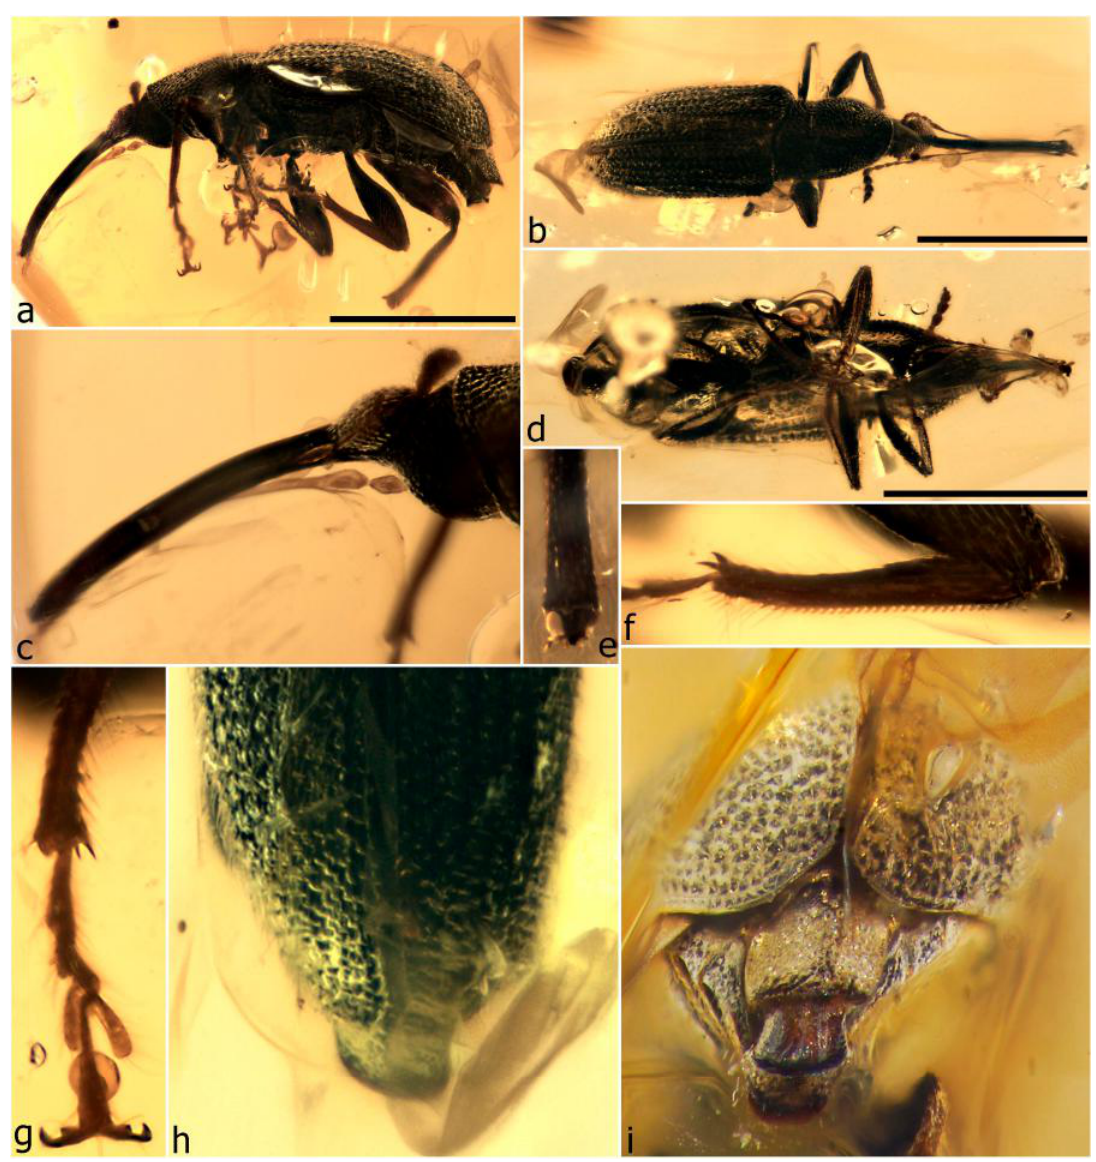
Figure 86. Bowangius tanaops sp. n., holotype. Habitus, left lateral ( a ); habitus, dorsal ( b ); head, left lateral ( c ); habitus, ventral ( d ); apex of rostrum and mouthparts, dorsal ( e ); left metatibia ( f ); left protarsus ( g ); apical half of elytra and exposed tergite VII, dorsal ( h ); apex of abdomen and elytra, caudal ( i ). Scale bars: 1.0 mm (a,b,d).